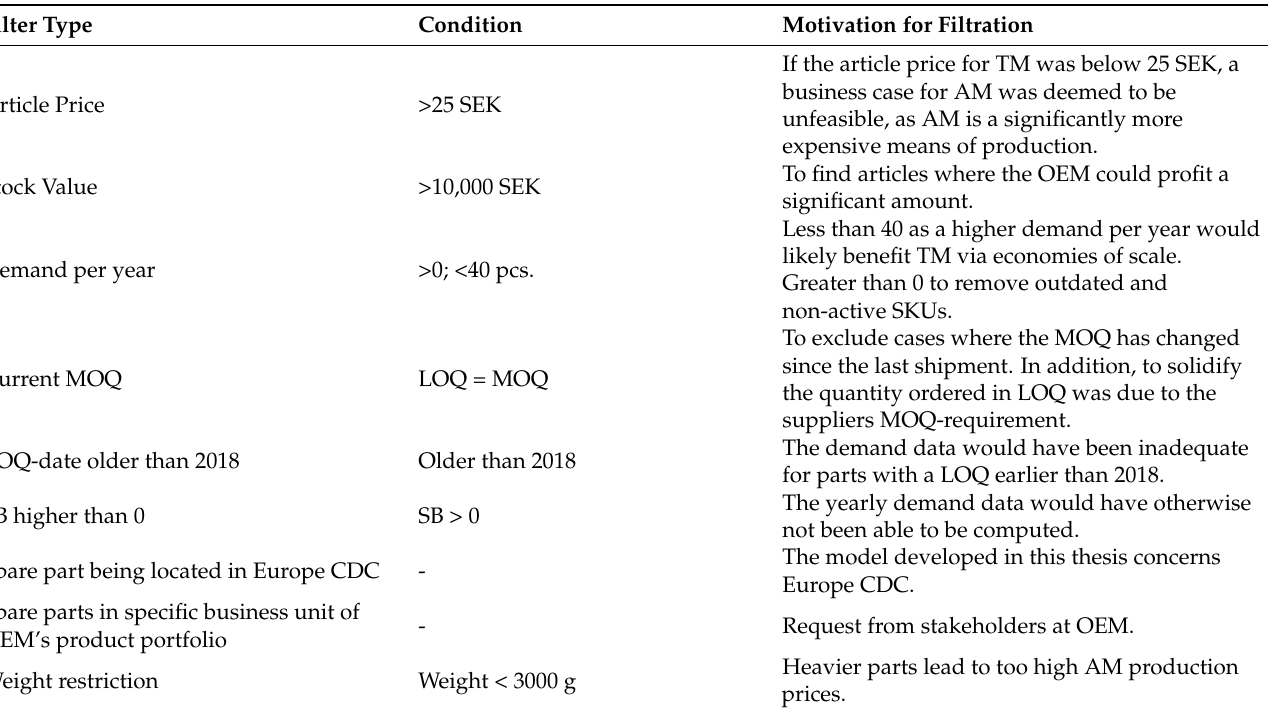
Table A2. Financial spare parts filtration over inventory